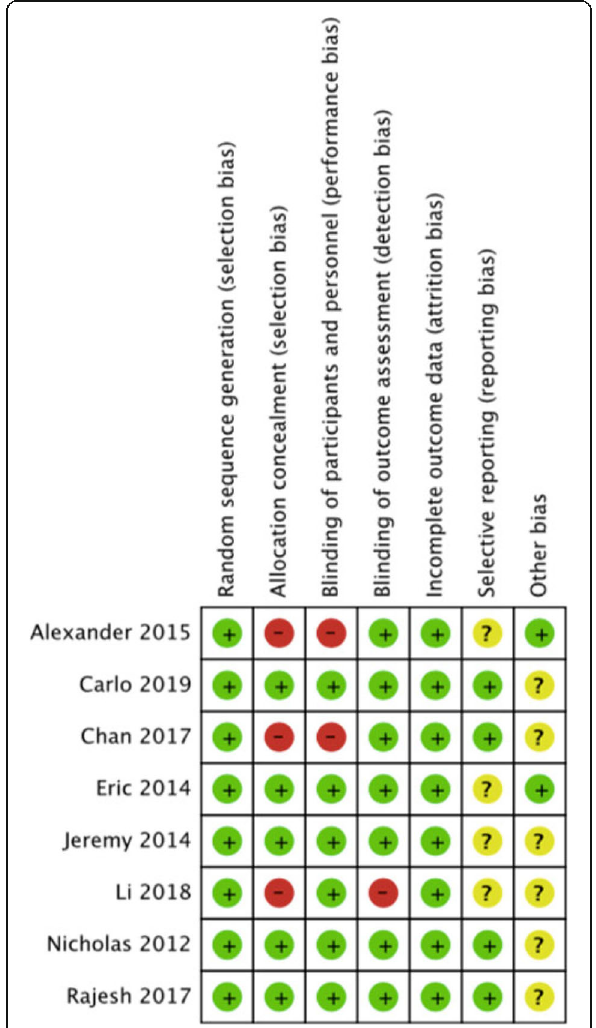
Fig. 3 Risk of bias summary for randomized controlled trials